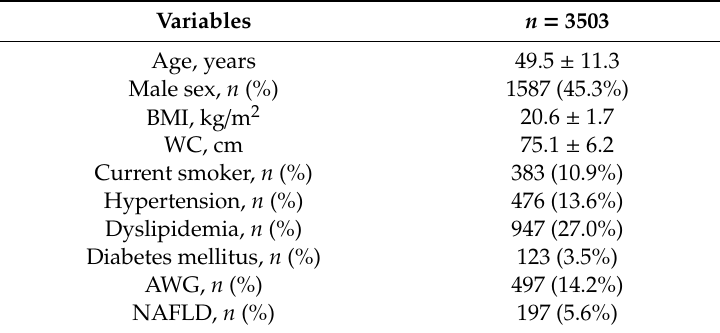
Figure 1. Selection procedure of participants. AWG, adult weight gain; BMI, body mass index; HBs-Ag, hepatitis B virus surface antigen; HCV-Ab, hepatitis C antibody (HCV-Ab). Table 1. Background characteristics of the study participants.